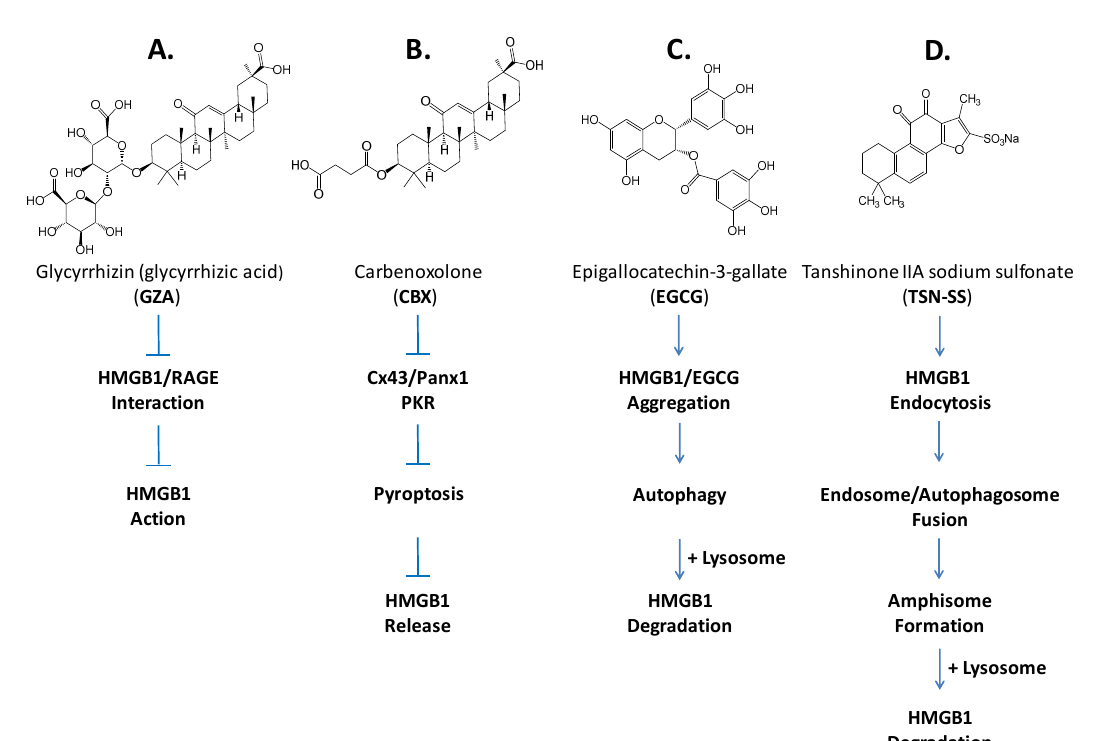
Figure 4. Distinct mechanisms of several pharmacological inhibitors of HMGB1 release or action. Different herbal compounds or derivatives inhibit HMGB1 release or action through distinct mechanisms that include: ( A ) direct binding to inhibit its engagement with various PRRs; ( B ) direct binding to induce its aggregation and autophagic degradation; ( C ) inhibition of key signaling molecules (PKR and hemichannels) involved in inflammasome activation and pyroptosis; and ( D ) induction of its endocytosis and lysosome-dependent degradation.